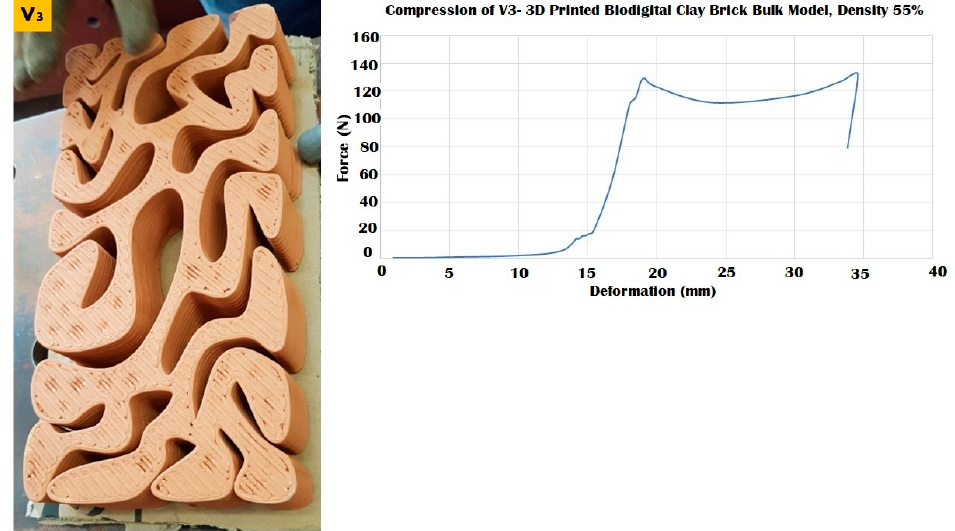
Figure 15. Exhibits the bulk brick model of the V3 family of the biodigital clay bricks with 55% density in the physical 3D-printed model ( left ). The graph exhibits the results of the compression test for this brick, showing the relation between force (N) ( Y -axis) and deformation (mm) ( X -axis). The maximum durability was achieved for the V3 bulk brick model at 17 mm under 130 N and maintained resistance until 34 mm under 135 N, where it totally collapsed.